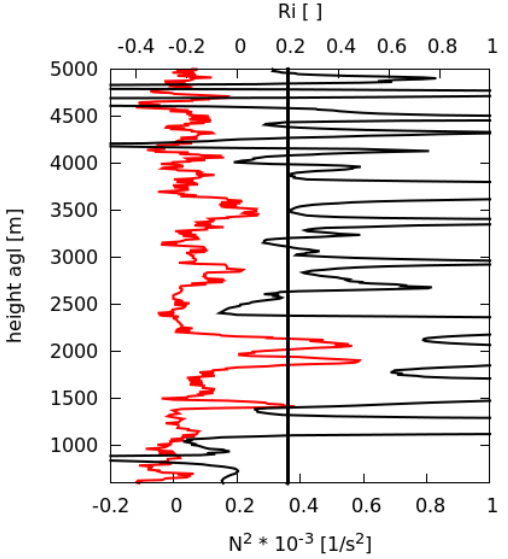
Figure 10. The profiles of the dimensionless gradient Richardson number Ri and the squared Brunt–Vaisala frequency N 2 (1/s 2 ) (red curve). Profiles are based on the Munich radiosonde data. Also shown is the critical Richardson number of 0.2. The flow supports turbulence for Ri < 0.2. Below 1000m, the atmospheric conditions are favorable for turbulence. Layers potentially supporting turbu- lence are found between 1000 and 4000m.